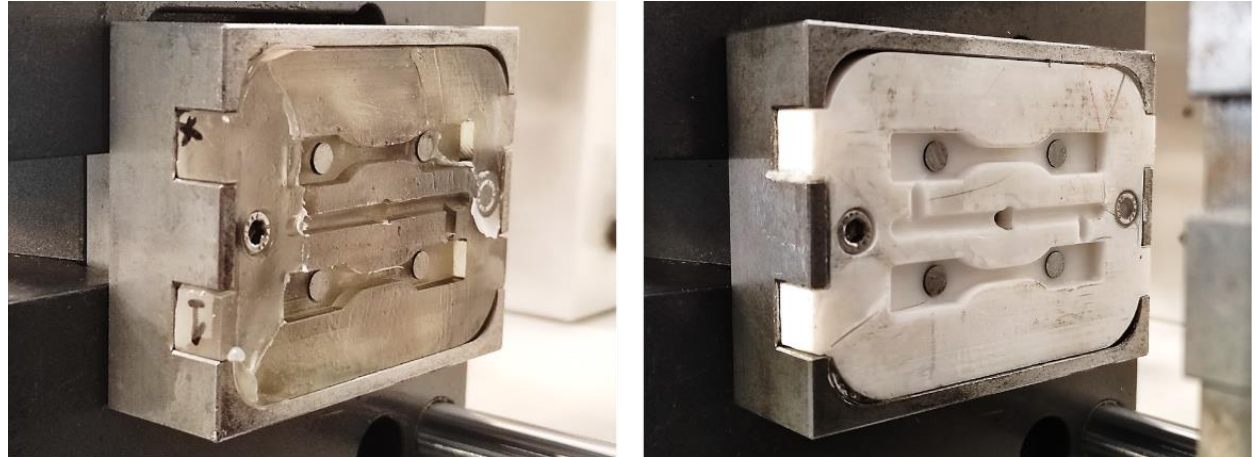
Figure 5. Photographs of the failure modes of the different photoresin mould inserts. HighTemp inserts ( left ) presented a trend of breaking in a brittle manner into several pieces, whilst Rigid 10k inserts ( right ) had cracks spanning radially from the ejector pins to the closest edges.